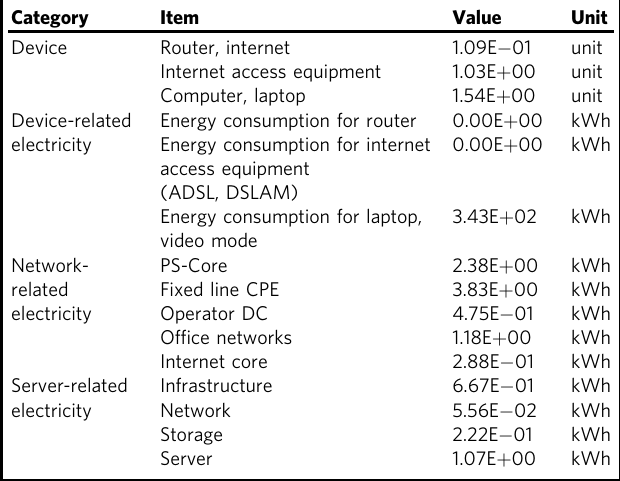
Table 5 Material and energy consumption of